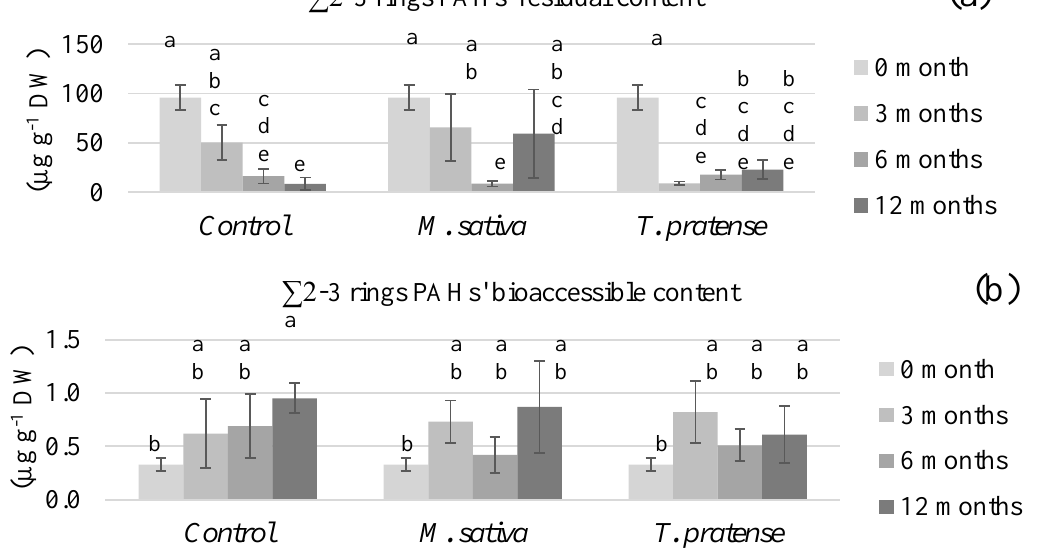
Figure 3. The light PAHs’ (∑2–3 rings) ( a ) residual and ( b ) bioaccessible content of soils planted with M. sativa L. or T. pratense L. compared to unplanted control samples after different time periods. The values are means ± confidence interval (α = 5%, n = 5). There is a significant interaction between the type and the time of culture, so within each PAH fraction (residual or bioaccessible) sticks that share the same letter are not significantly different ( p > 0.05).